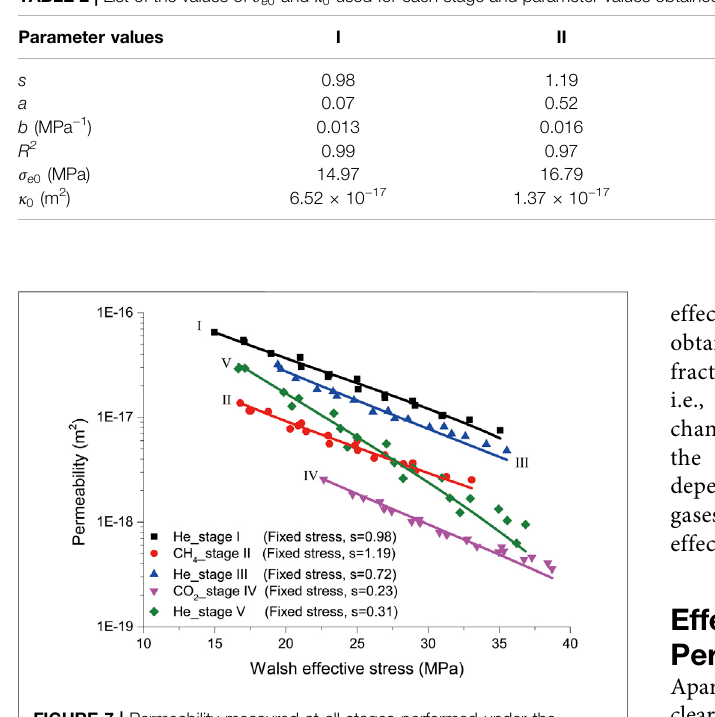
Frontiers in Earth Science |